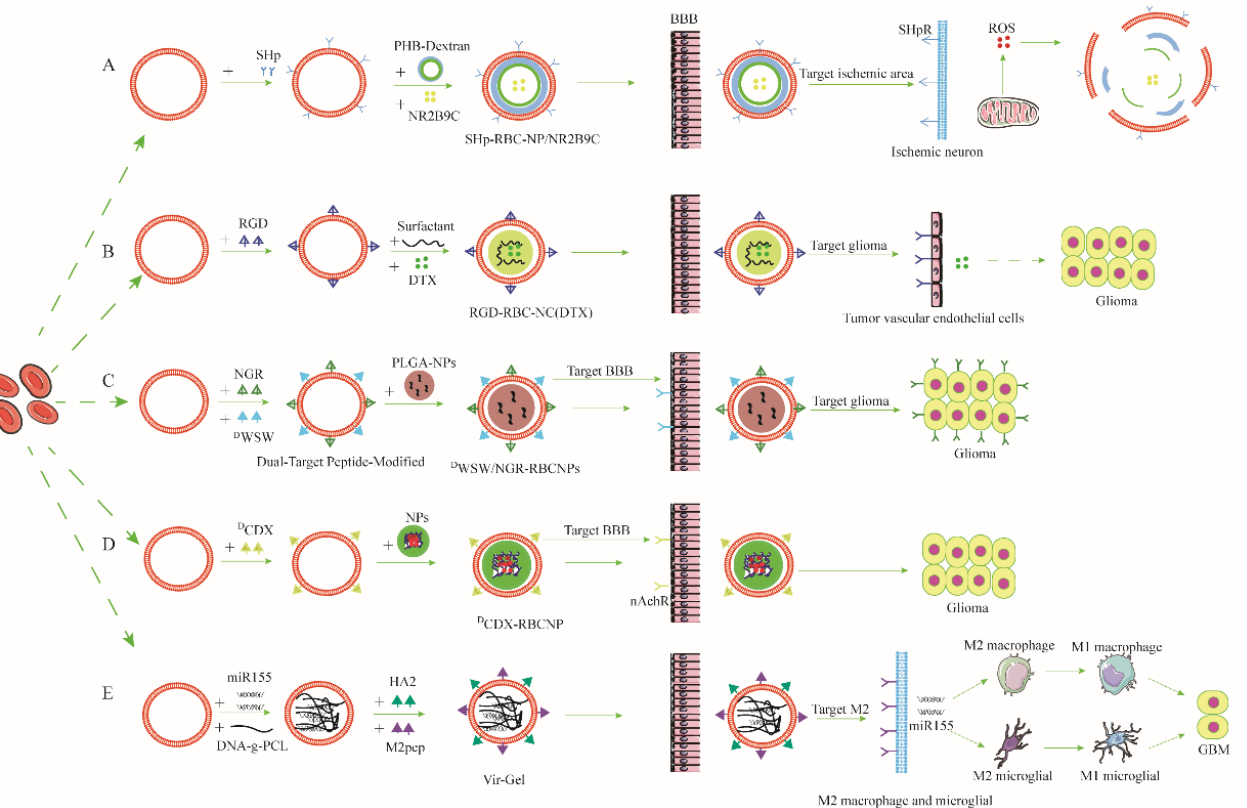
Figure 1. The preparation and characterization of red-cell-membrane-coated nanoparticles for ND drug delivery. ( A ) The preparation and characterization of SHp-RBC-NP/NR2B9C for ischemic stroke drug delivery; ( B ) the preparation and characterization of RGD-RBC-NC(DTX) for glioma drug delivery; ( C ) the preparation and characterization of D WSW/NGR-RBCNPs for glioma drug delivery; ( D ) the preparation and characterization of D CDX-RBCNP for glioma drug delivery; and ( E ) the preparation and characterization of Vir-Gel for glioblastoma drug delivery. 2.1.2. White-Cell-Membrane-Coated Nanoparticles (WCMCNPs) Table 1. Summary of white-cell-membrane-coated nanoparticles for ND drug